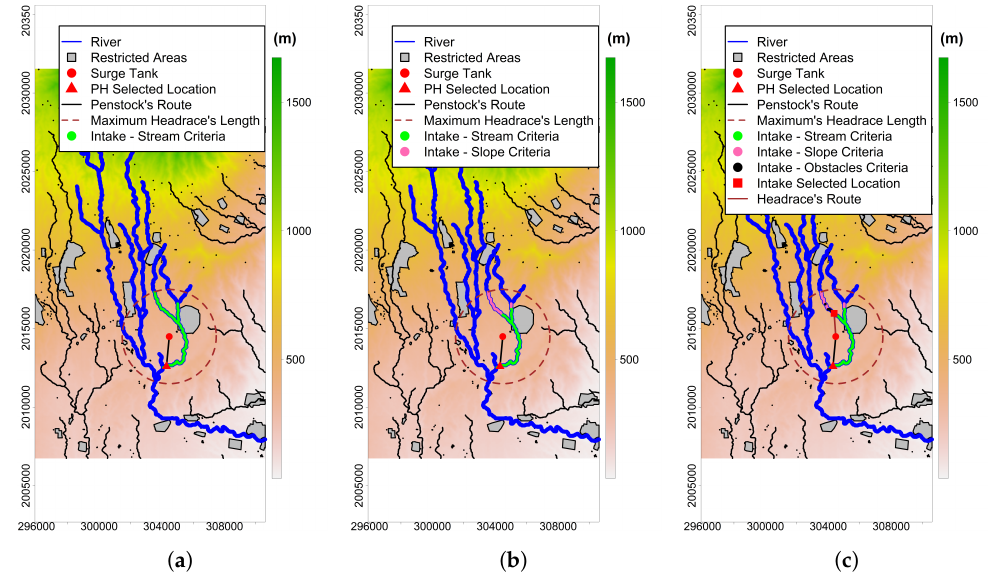
Figure 4. Intake site selection process. ( a ) Stream criteria ( b ) Slope criteria ( c ) Obstacles criteria. Maximum permissible headrace’s length for example is set to R I = 3000 m.